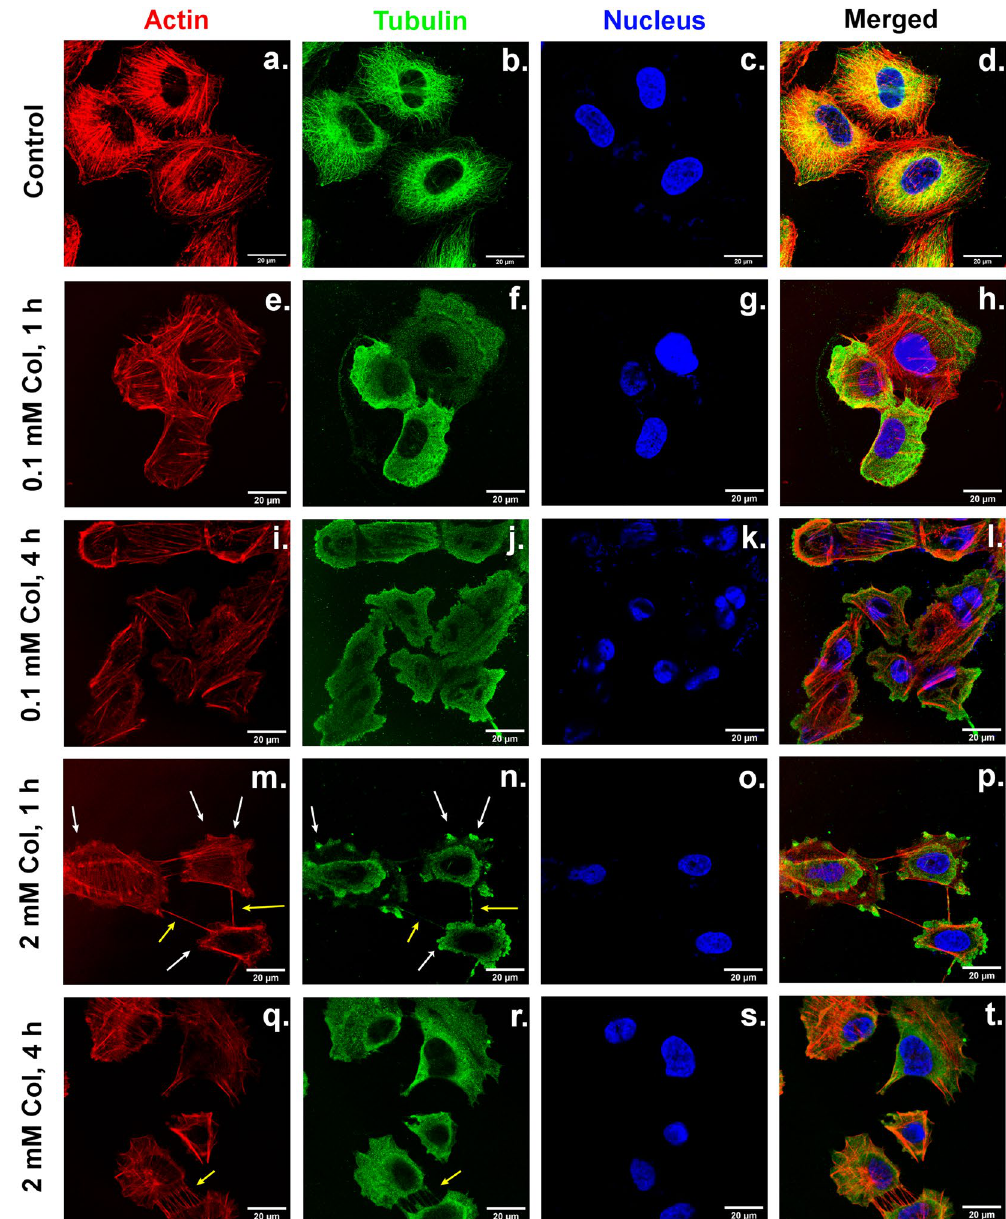
Figure 2. Confocal laser scanning fluorescence microscopy of cells for control, 0.1 mM and 2 mM with actin filaments (red), microtubules (green), nucleus (blue), and a composite image of all stainings. Panels (a–d) show the control cells. Panels (e–h) depict 1 hour of 0.1 mM Colchicine exposure. Panels (i–l) shows 4 hours of 0.1 mM treatment, Panels (m–p) illustrate the effect of 2 mM Colchicine after 1 hour. Panels (q–t) refer to 2 mM Colchicine for four hours treatment. White arrows indicate protrusions while yellow arrows show tethers between cells. The scale bar corresponds to 20 µ